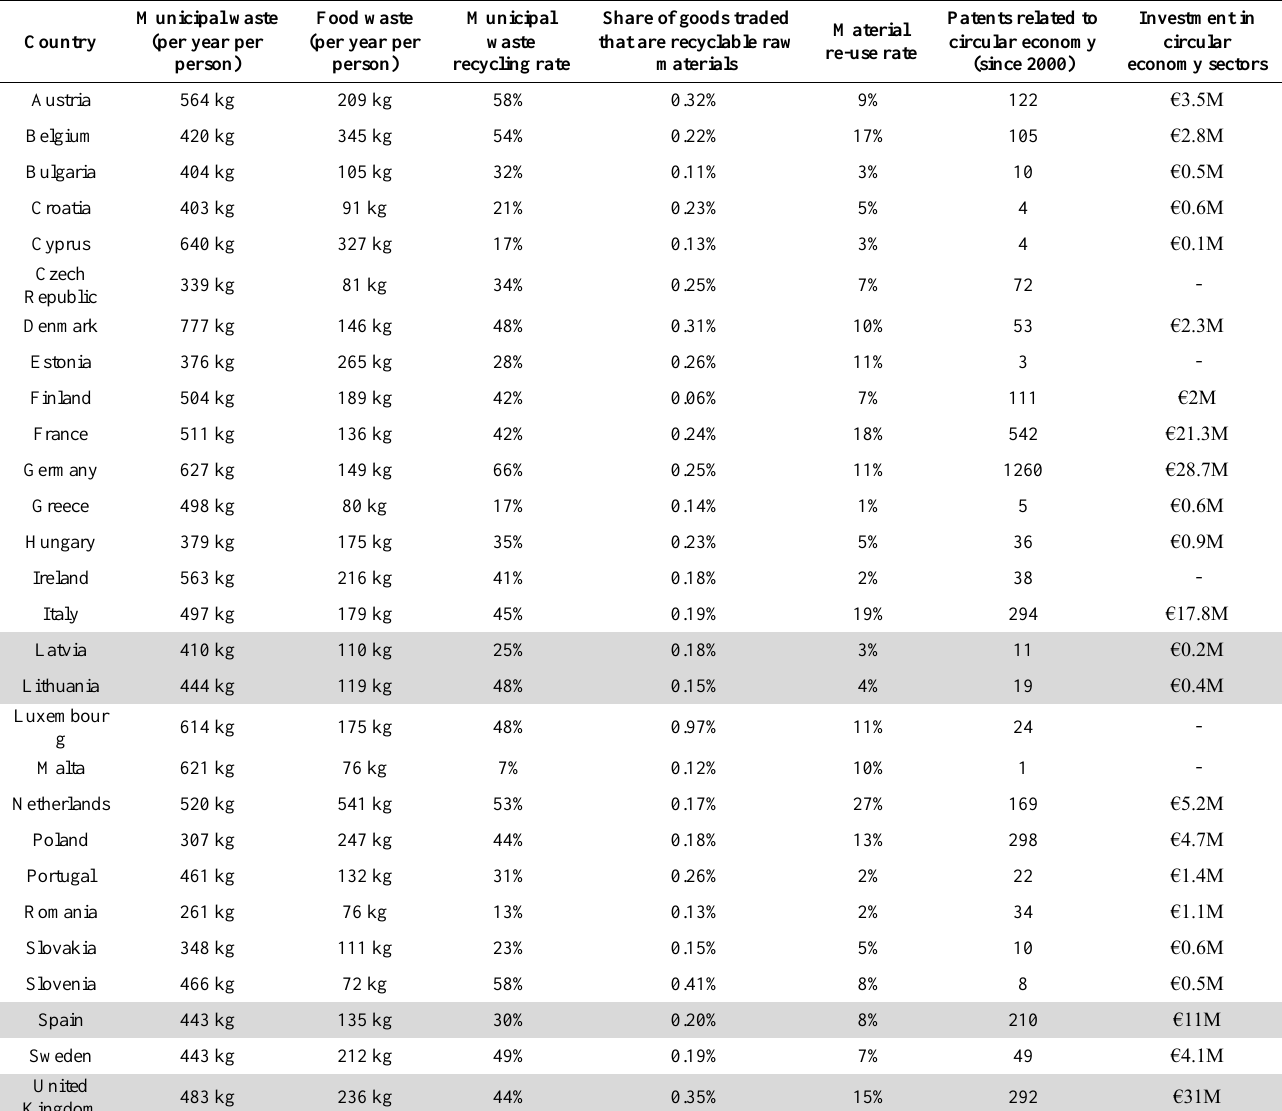
Table 1. The circular economy ranking in the EU in 2018, (POLITICO, 2018)